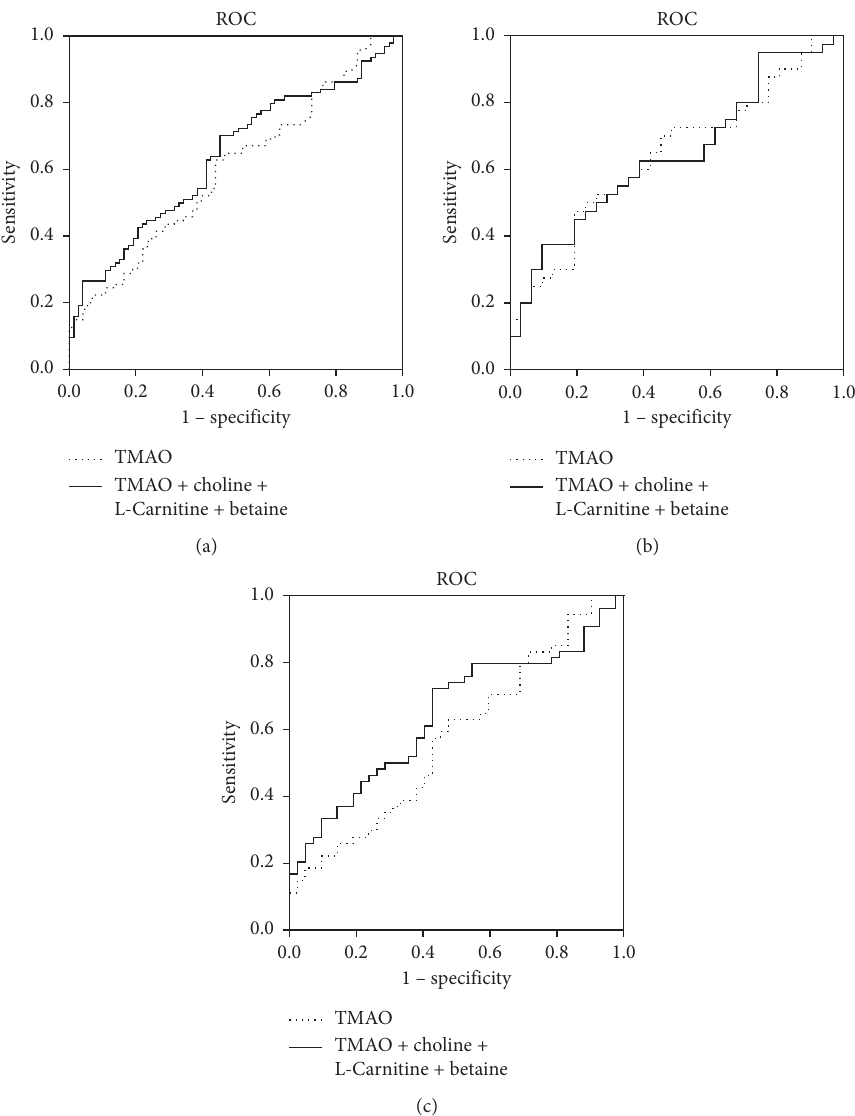
Figure 3: ROC curves of betaine, choline, L-carnitine, and TMAO for discriminating CAD from CON in all, male, and female participants. AUC indicates area under the receiver-operating characteristic curve. (a) All; (b) male; (c)